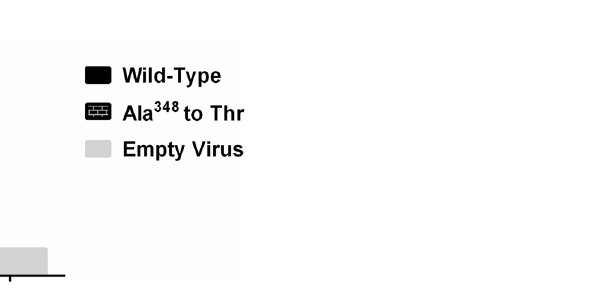
Figure 2. mRNA expression levels of P2X7R in THP-1 cells carrying Ala 348 to Thr, Wild-Type and Empty Virus. * P <